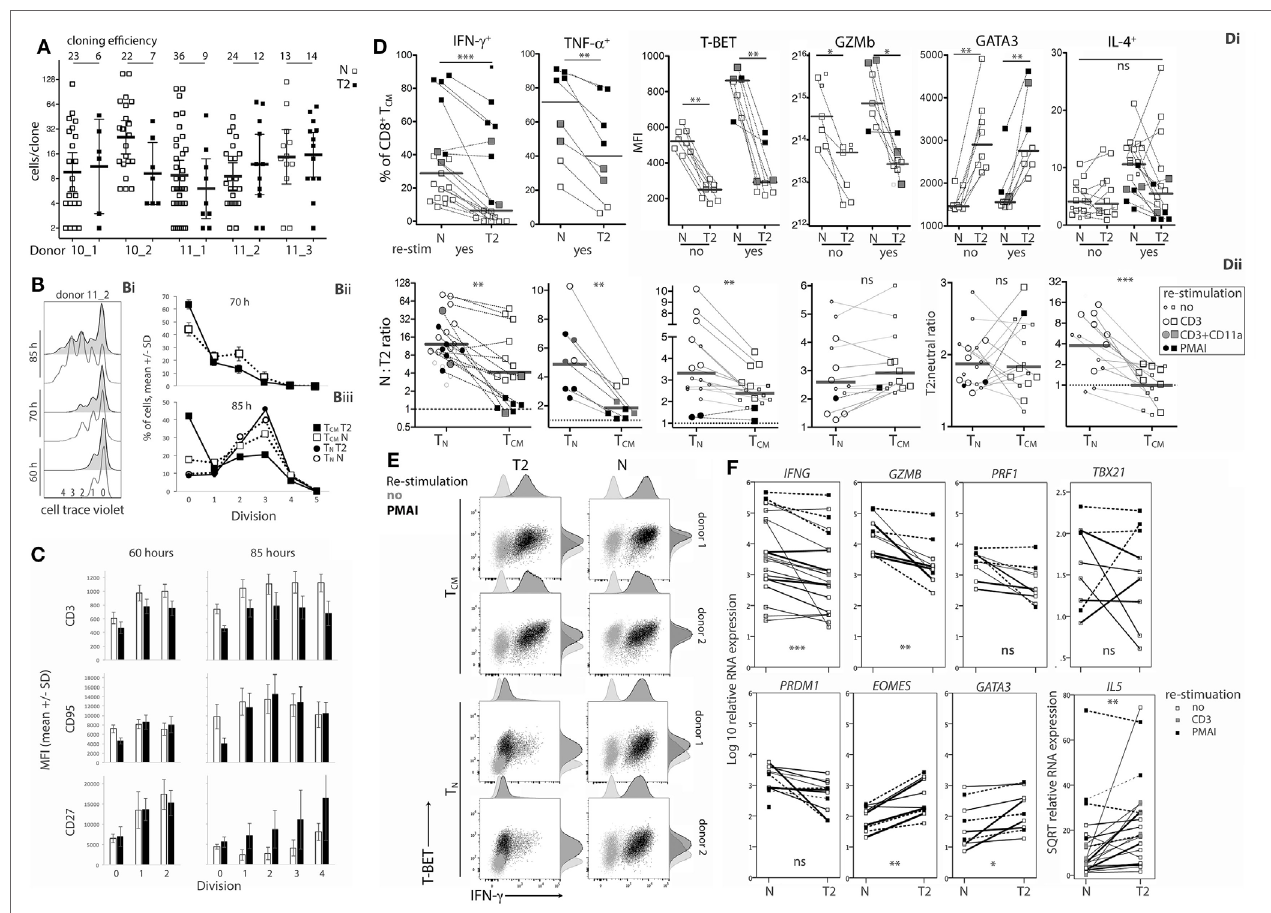
FigUre 5 | Effects of type-2 (T2) conditions on division and differentiation of CD8 + T CM following secondary activation. (a) Single T CM cell cloning in neutral versus T2 conditions as in Figure 1a . (b) Division analysis as in Figure 1b . Line graphs show mean and SD for T CM from three donors at 70 h (Bii) and for T CM and T N from the same three donors at 85 h (Biii). (c) Surface receptor expression according to division number. The mean and SD of results for three donors and two time-points are shown. (D) Cytokine and transcription factor levels in T CM from each donor, time and restimulation type; lines join neutral and T2 conditions. Levels in T CM and T N in neutral versus T2 conditions are presented as ratios in Dii. Horizontal bars represent medians. (e) Overlay plots of IFN- γ versus T-BET staining of cells with and without PMA and ionomycin (PMAI) restimulation, comparing neutral versus T2 conditions for T N and T CM from two donors. (F) mRNA levels for T CM activated in neutral versus T2 conditions, as in Figure 3 . p -Values for pairwise comparisons of neutral versus T2 are indicated (**** p < 0.0001, *** p < 0.001, ** p < 0.01, and * p <